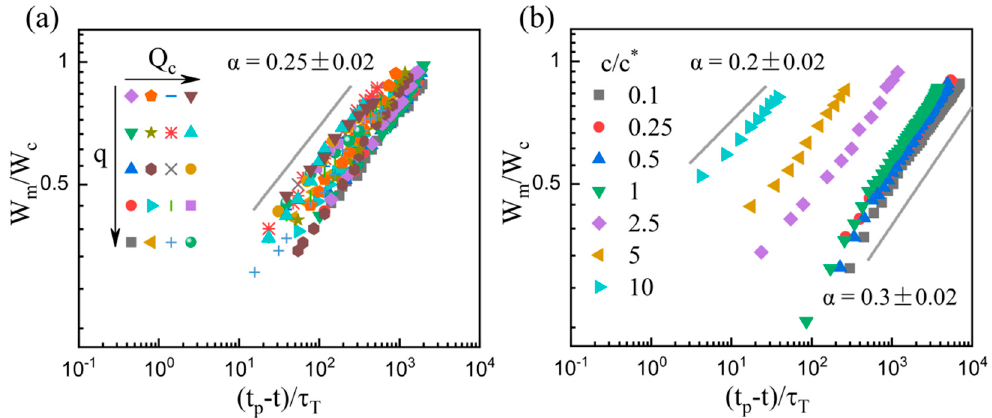
Figure 7. Plots of the dimensionless minimum width W m / W c of the dispersed filament to the dimensionless remaining time ( t p − t )/ τ T for c = 2.5 c * under different flow conditions ( a ) and for different concentrations ( b ). In (a), q = 1–16 and Q c = 20–160 μ L/h. In (b), q = 2 and Q c = 40 μ L/h. All grey lines are provided to guide the eye.